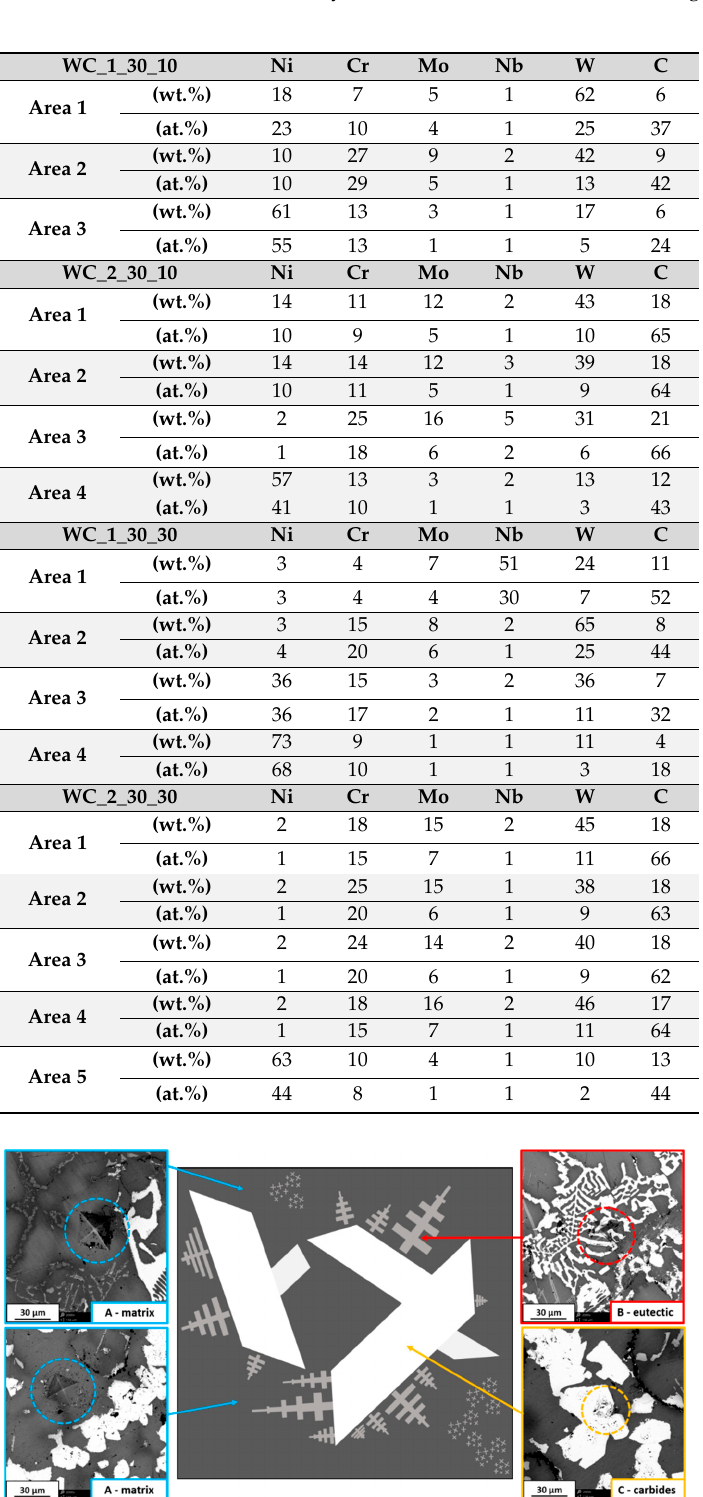
Table 4. SEM / EDS element concentration analysis results for areas marked in Figure 7 for each of samples.